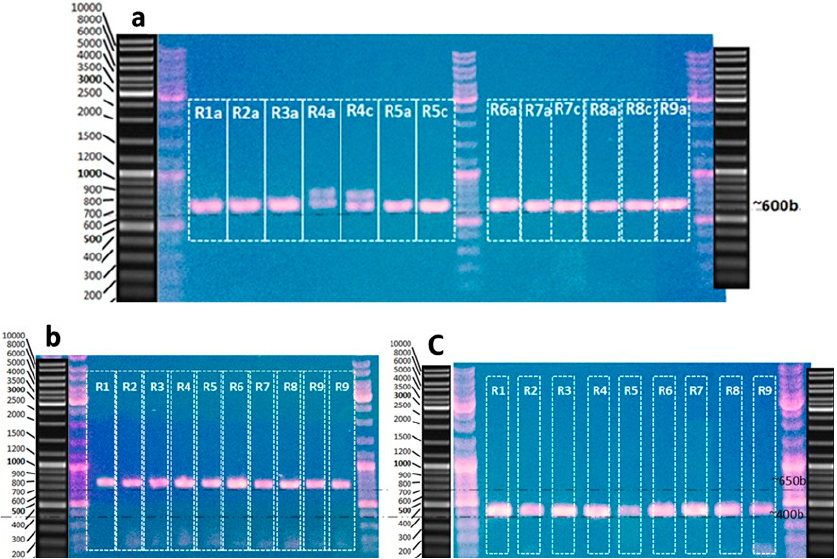
Figure 2. Gel electrophoresis with amplified Phusion PCR products for ( a ) LSU barcode of nine different Hypnea sp. extracted with PowerPlant (indicated by a) or DNeasy DNA extraction kit (indicated by c, i.e. , R4, R5, R7, and R9); ( b ) COI barcode with amplified Phusion PCR products, and